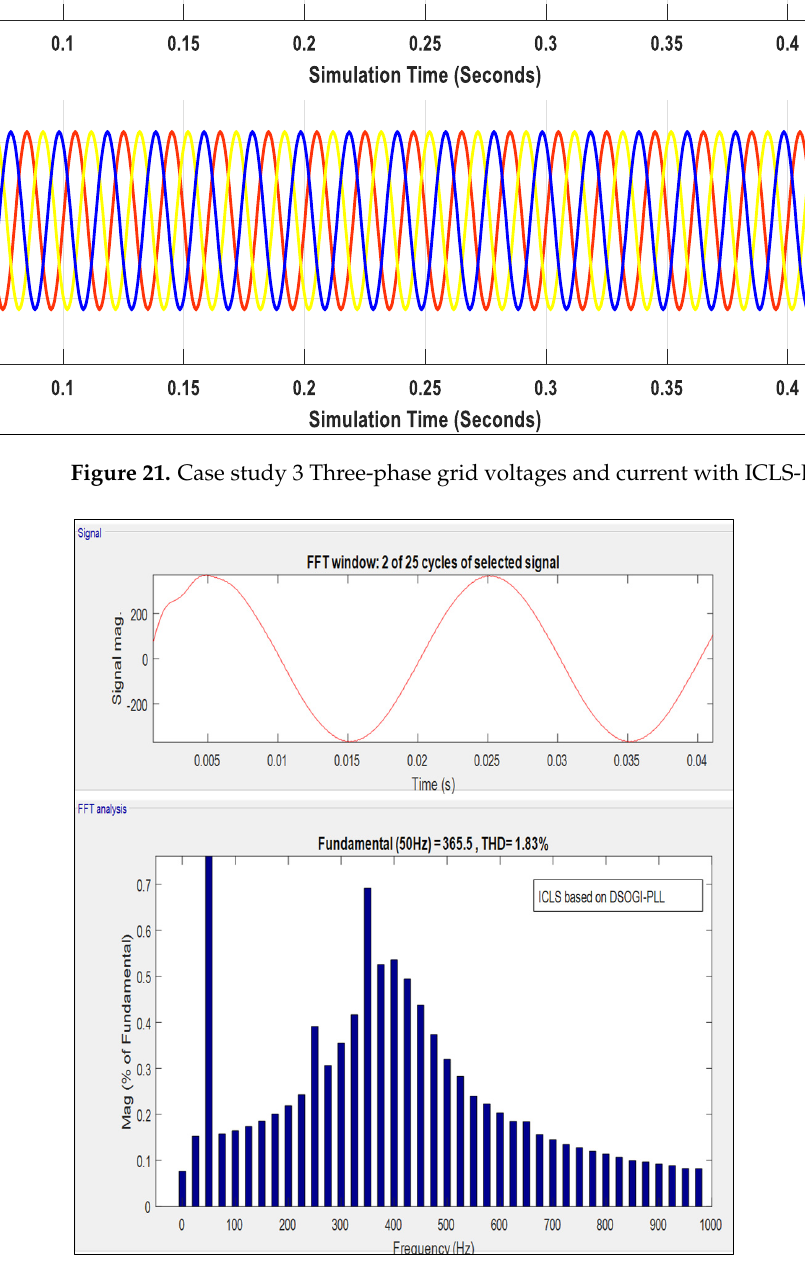
Figure 22. The THD case study 3 performance results with ICLS-DSOGI-PLL.